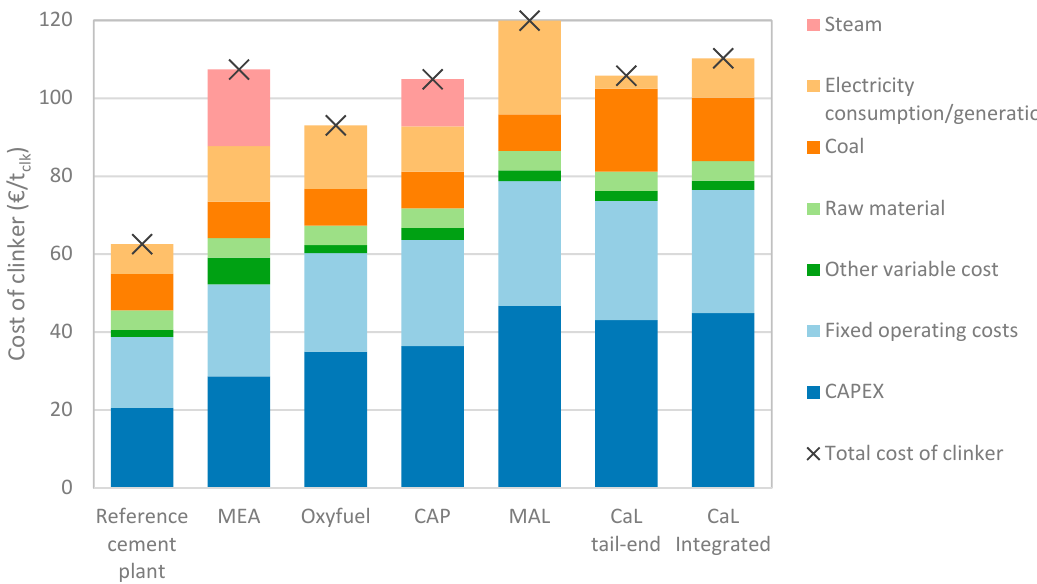
Figure 4. Break-down of cost of clinker for the reference cement plant and all the investigated CO 2 capture technologies.